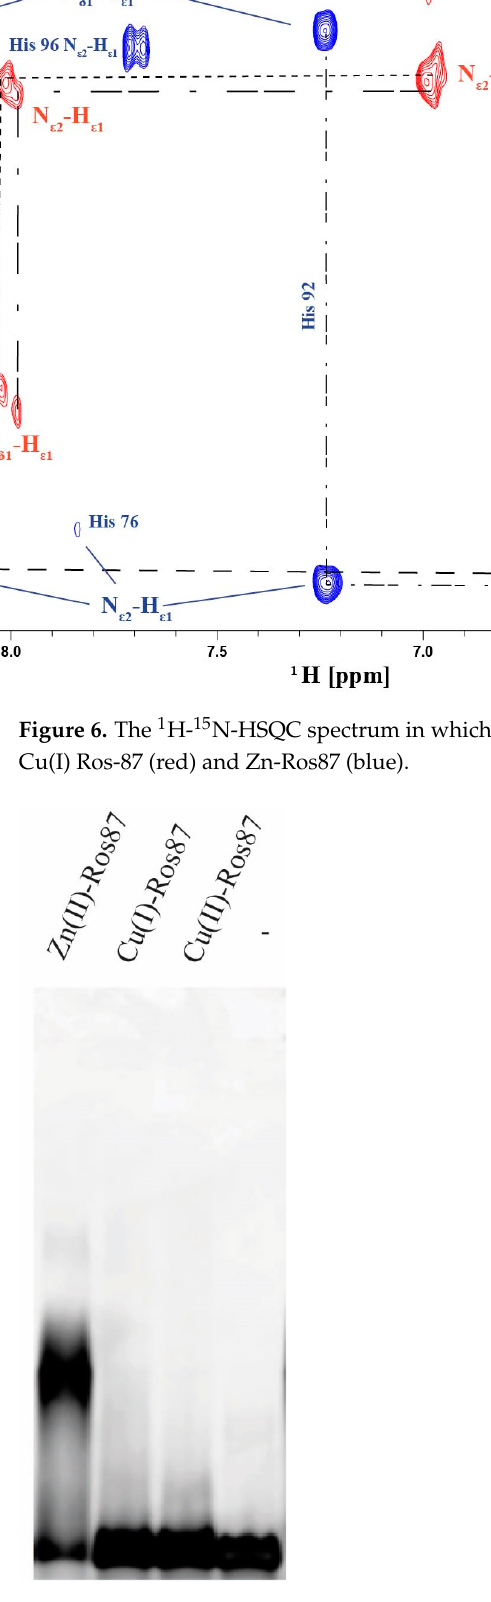
Figure 7. EMSA experiments. Each protein tested is indicated on the top of the image.